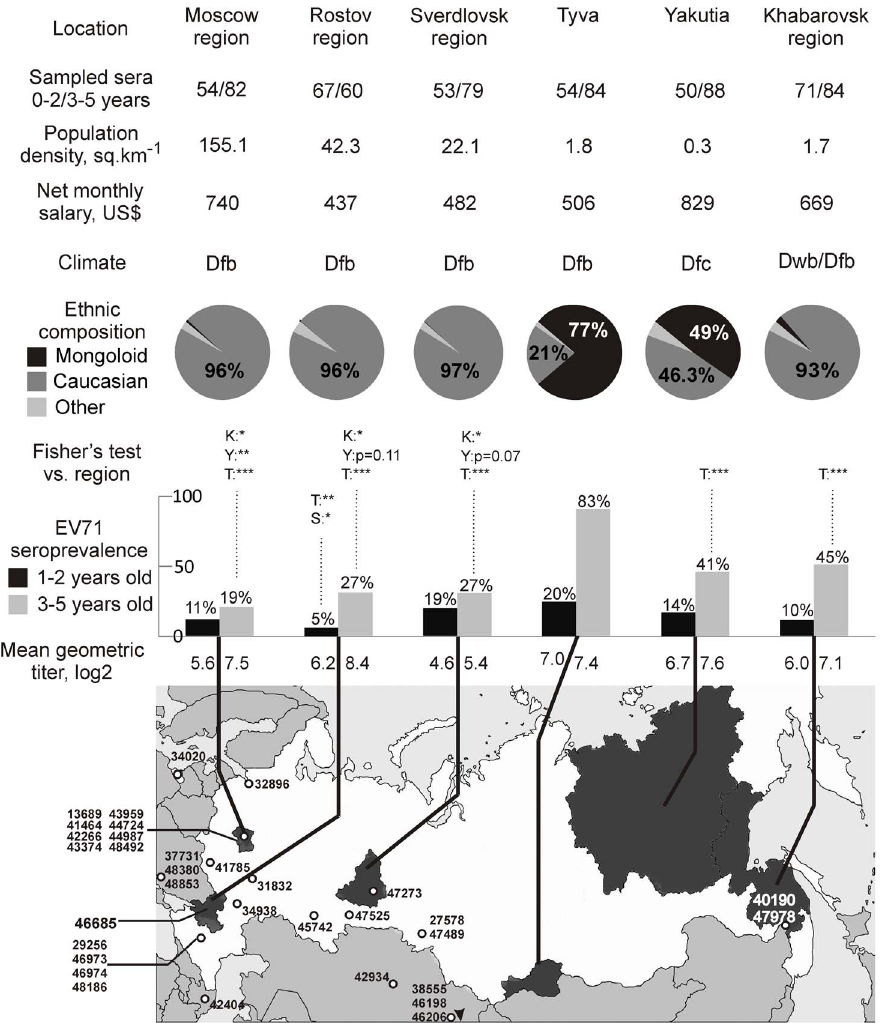
Figure 1. The subjects were randomly sampled by computer- assisted selection from an address book in 2007–2008 for a study on hepatitis A seroprevalence. Only sex and age of study subjects were recorded, information on ethnic background and travel history of individuals were not available. Written informed consent was obtained from all subjects or their legal representatives. The study was approved by the Ethical Committee of the Chumakov Institute of Poliomyelitis and Viral Encephalitides. A total of 831 sera from healthy children aged 1–5 years and from 30 adults were used for this study. The children were further divided into two groups of 1–2 and 3–5 years of age because the latter corresponds to a common age of kindergarten admission in Russia. Information on social and economic factors was derived from the official 2006 census data [12], climate zones in the sampling regions according to were provided according to the updated Ko¨ppen classification [13].